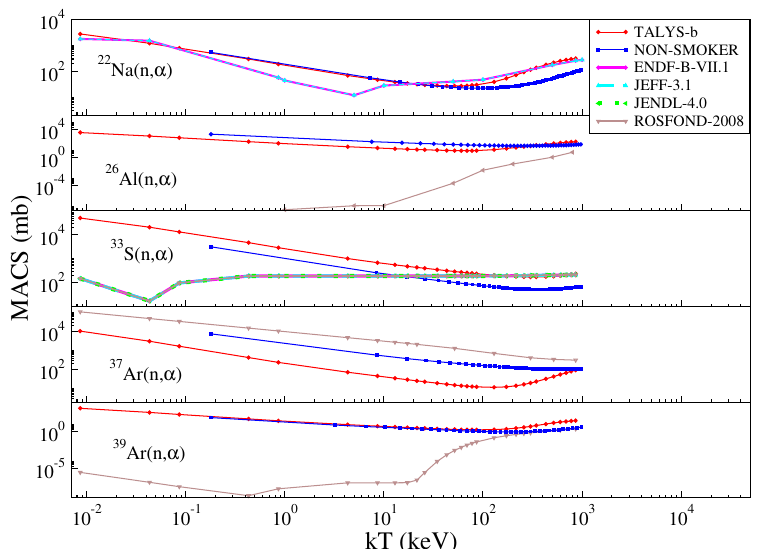
Figure 4. The Maxwellian averaged cross sections (MACS) for ( n , α ) reaction for 22 Na, 26 Al, and 33 S, 37 Ar, and 39 Ar as functions of temperature. The present results (TALYS-b) are compared to those from NON-SMOKER [8], ENDF-B-VII.1 [7], JEFF-3.1 [30], JENDL-4.0 [10], and ROSFOND-2008 [11].